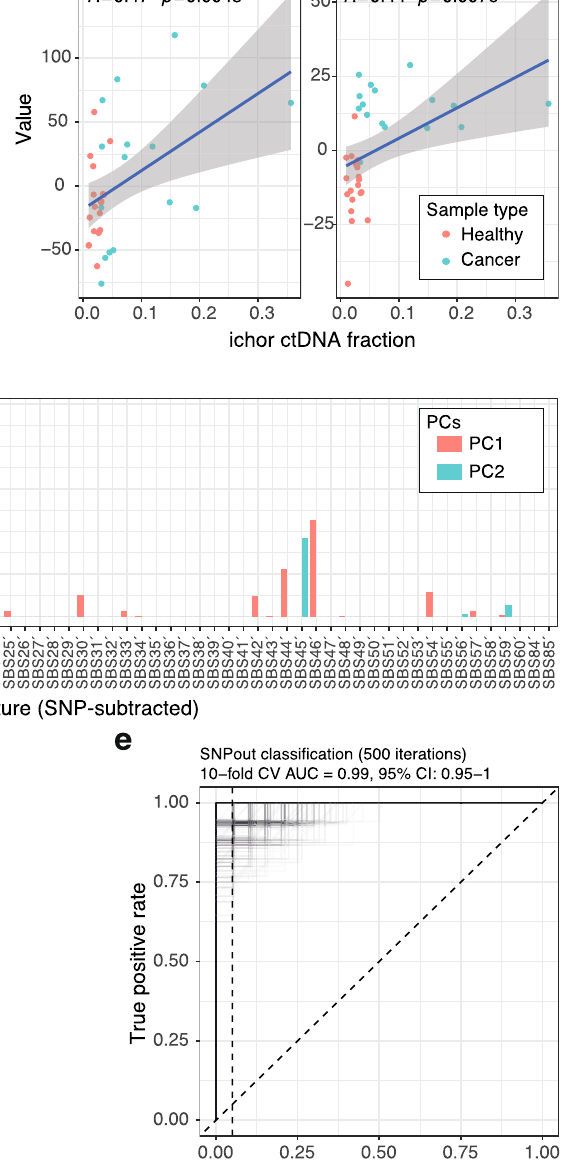
subtractedmutation data fi tted to SBSn, where n isaninteger. PC1 is shown inred, PC2 is shown in blue. d In samples from healthy individuals ( n =19) and patients with stage IV CRC ( n =16), SBS1 contribution was signi fi cantly correlated with SBS8´ ( p =5.6 × 10 − 5 , two-sided Pearson correlation). Healthy and cancer samples are shown in red and blue, respectively. The gray shaded area indicates the 95% con fi denceintervalofthe fi ttedlinearmodel. e Arandomforestmodelwasusedto classify cancer samples ( n =16) vs. healthy ( n =19) using SNP-subtracted mutation pro fi les. Ten-fold nested cross-validation repeated 500 times was used. Each iteration is shown. A Receiver Operating Characteristic curve is shown (AUC 0.99, 95% CI 0.95 – 1.00). Source data are provided as a Source data fi le. AUC area under the curve, CV